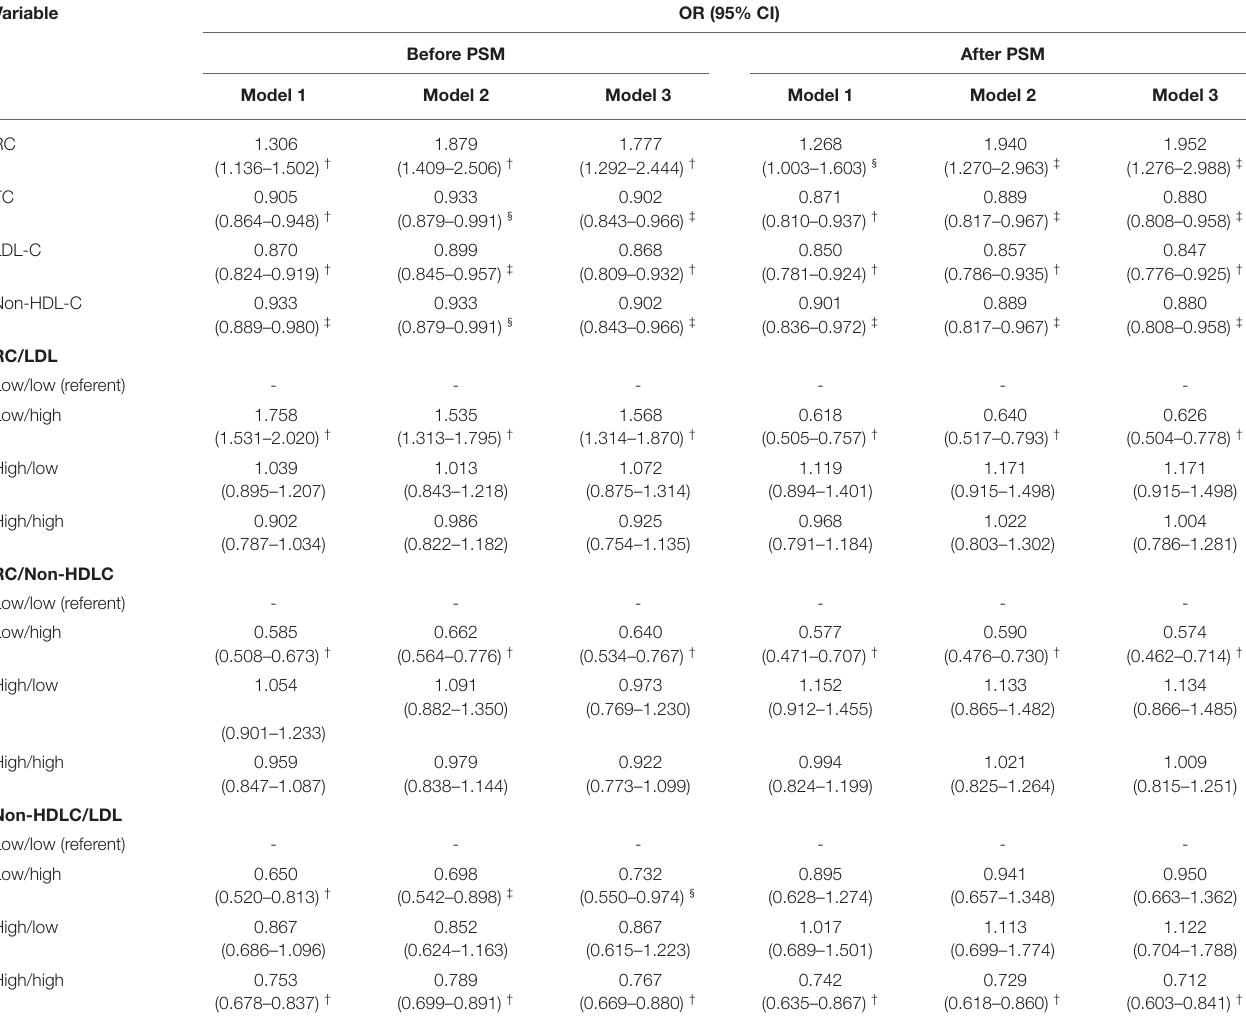
TABLE 3 | The multivariate logistic regression analyses of the risk of coronary artery disease